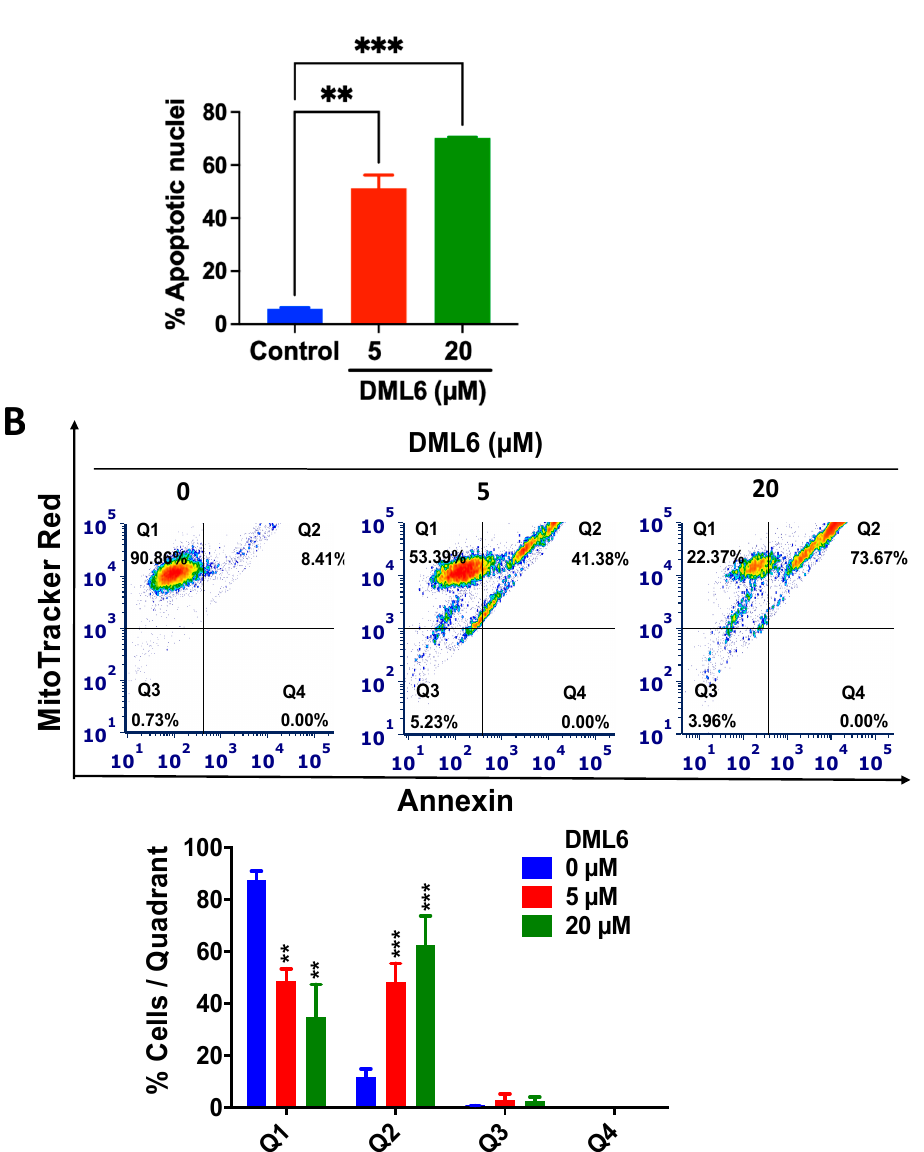
Figure 5. The effect of DML6 on apoptosis and the mitochondrial membrane potential. ( A ) Changes in the nuclear morphology in OV2008 cells incubated with the vehicle (0 µ M), 5, or 20 µ M of DML6 . The cells were fixed and stained with the DNA binding dye, Hoechst 33342. The nuclear fragmen- tation and apoptotic chromatin condensation are indicated by red arrows. Multiple decondensed micronuclei were observed using an EVOS fluorescent microscope at 20x magnification. Scale bar represents 200 μ m. A histogram quantitatively summarizing the % of apoptotic nuclei of cells incubated with 5 and 20 µ M of DML6 as compared to cells incubated with the vehicle, is also shown. ( B ) A representative figure showing DML6 induced apoptosis A histogram summarizing the results is also shown, ** p < 0.01, *** p < 0.001. The data represent the means ± SEM of three independent experiments performed in triplicate.